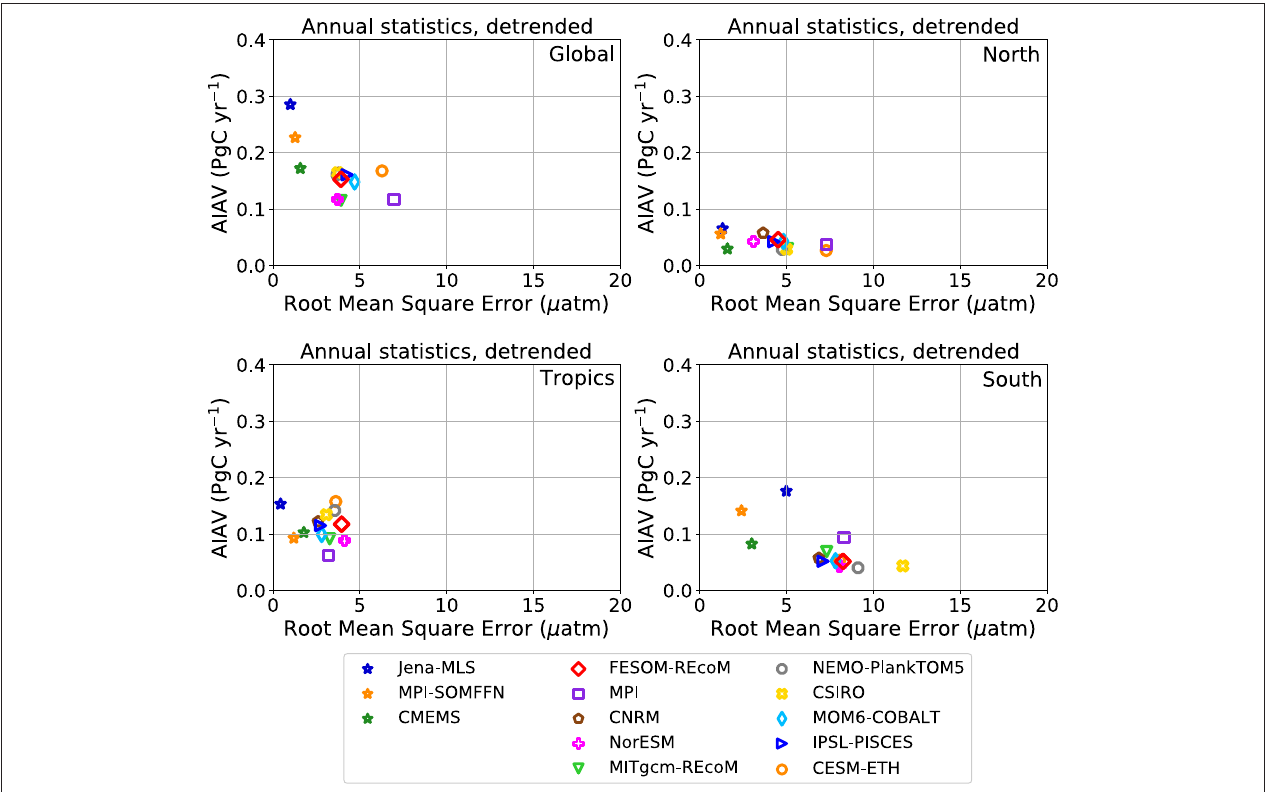
FIGURE 7 | Summary figure of temporal variability (y-axis) and model-data mismatch (x-axis). Mismatch of simulated or mapped p CO 2 and observed sea surface p CO 2 for the period 1992–2018 on the time-scale of multi-year variability and amplitude of interannual variability (AIAV) of CO 2 flux. x-axis: RMSE of spatially-averaged detrended annual time-series. y-axis: amplitude of interannual variability, defined as the standard deviation of the detrended annual time-series of air-sea CO 2 flux. These statistics are shown globally, and regionally for north, tropics, and south as indicated in the figure